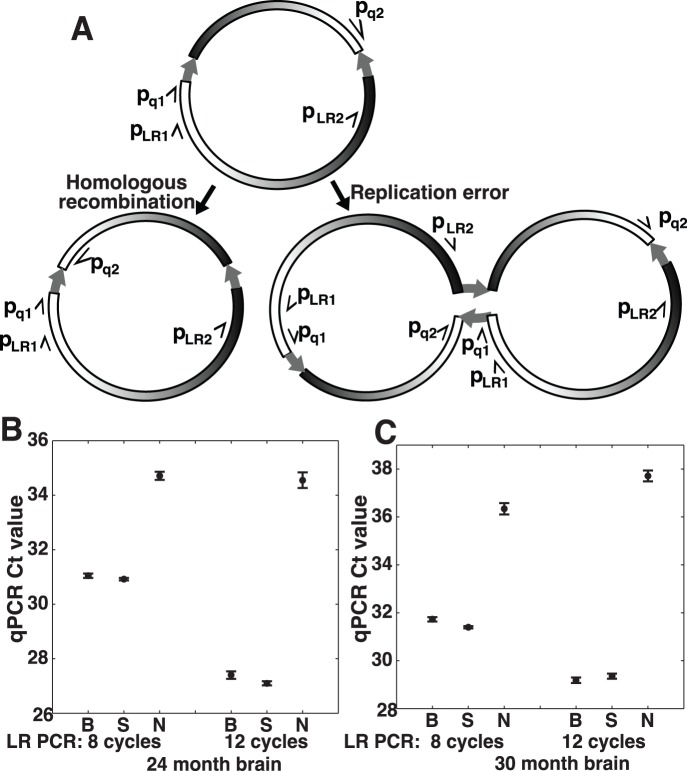
The majority of inversions are caused by mtDNA replication.(A) Diagram showing inversion products generated by recombination or replication mechanisms. IRs are indicated by thick arrows. Thin half-arrows indicate LR PCR primers (pLR1 and pLR2) and qPCR primers (pq1 and pq2) used to quantify the inversion. (B) Quantification of the recombination and replication inversion products using qPCR. Total DNA from a 24-months-old mouse brain was first amplified with 8 or 12 cycles of LR PCR with the primers pLR1 and pLR2 (B), pLR1 alone (S), or no primer control (N). Inversions resulting from replication errors can be amplified with pLR1 alone, while inversions resulting from homologous recombination require both pLR1 and pLR2 primers.. The LR PCR was followed by qPCR with primers pq1 and pq2 to specifically quantify the inversion. The Ct values, inversely proportional to log of template concentration, are plotted for each PCR reaction. Error bars indicate s.e.m. (n = 6 for N; n = 12 for groups B and S). (C) A replicate of (B) using the total DNA from a brain of a different mouse (30-months-old).